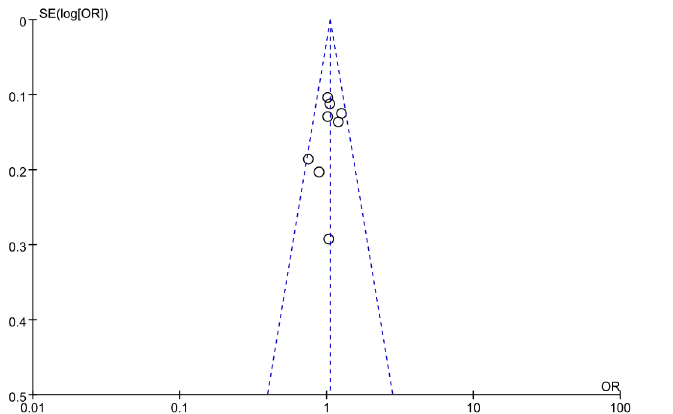
Fig 9. Funnel plot to detect publication bias in data on ADIPOR1 SNP rs7539542(C/G) according to a dominant